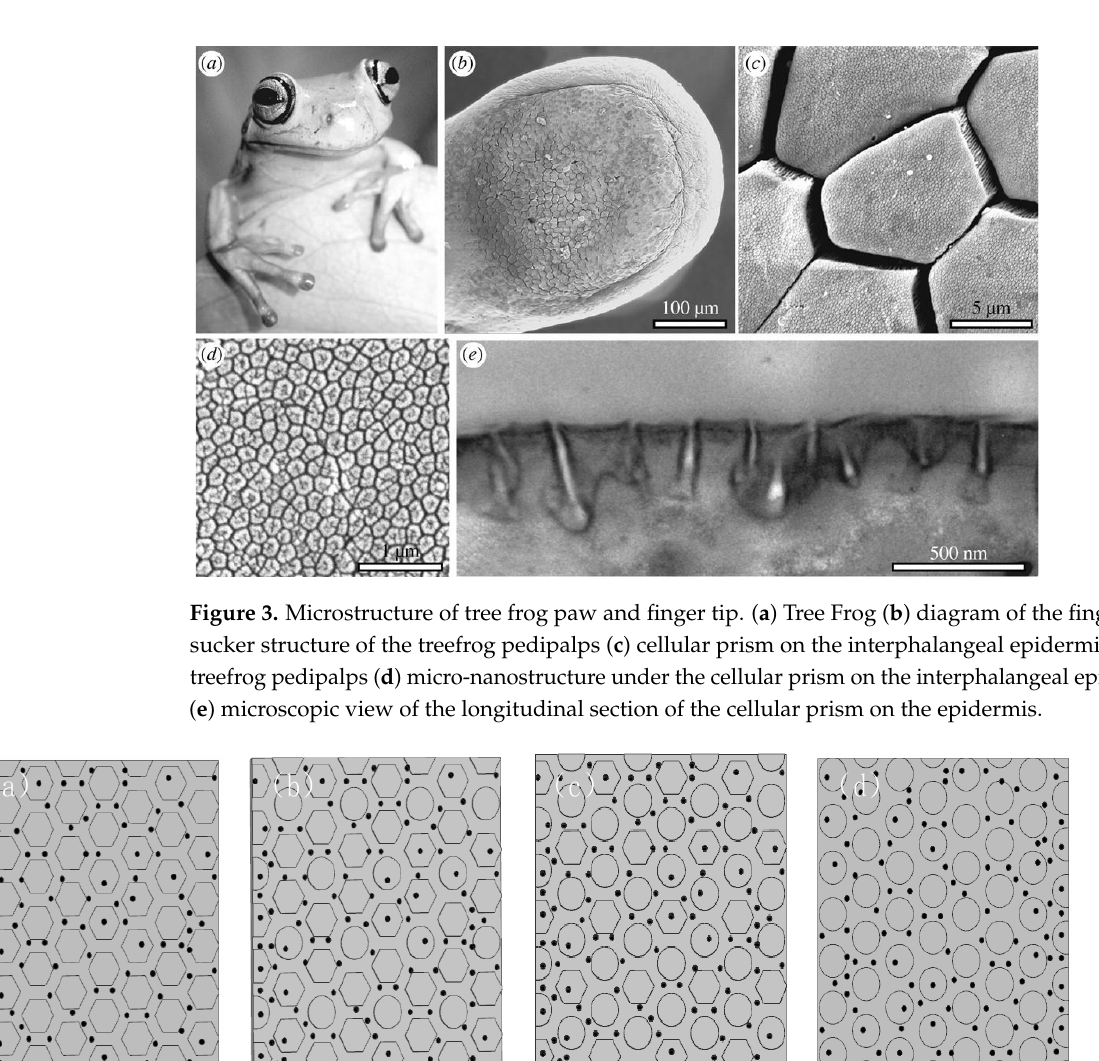
Figure 3. Microstructure of tree frog paw and finger tip. ( a ) Tree Frog ( b ) Surface morphology of the pedipalps of tree frogs (100 μm ) ( c ) Surface morphology of the pedipalps of tree frogs (5 μm ) ( d ) Surface morphology of the pedipalps of tree frogs (1 μm ) ( e ) Surface morphology of the pedipalps of tree frogs (500 nm).